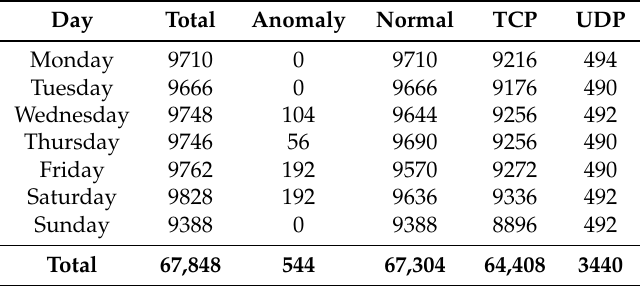
Table 7. Number of